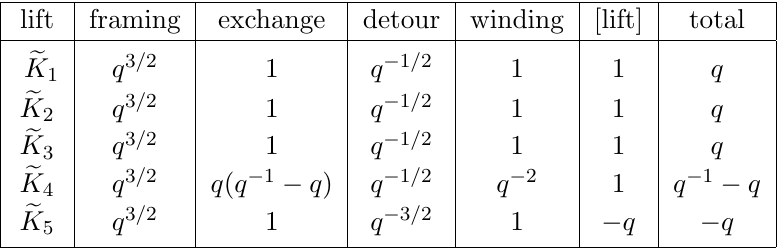
Table 3 . Summary for the (cid:12)ve lifts of the unknot K in (cid:12)gure